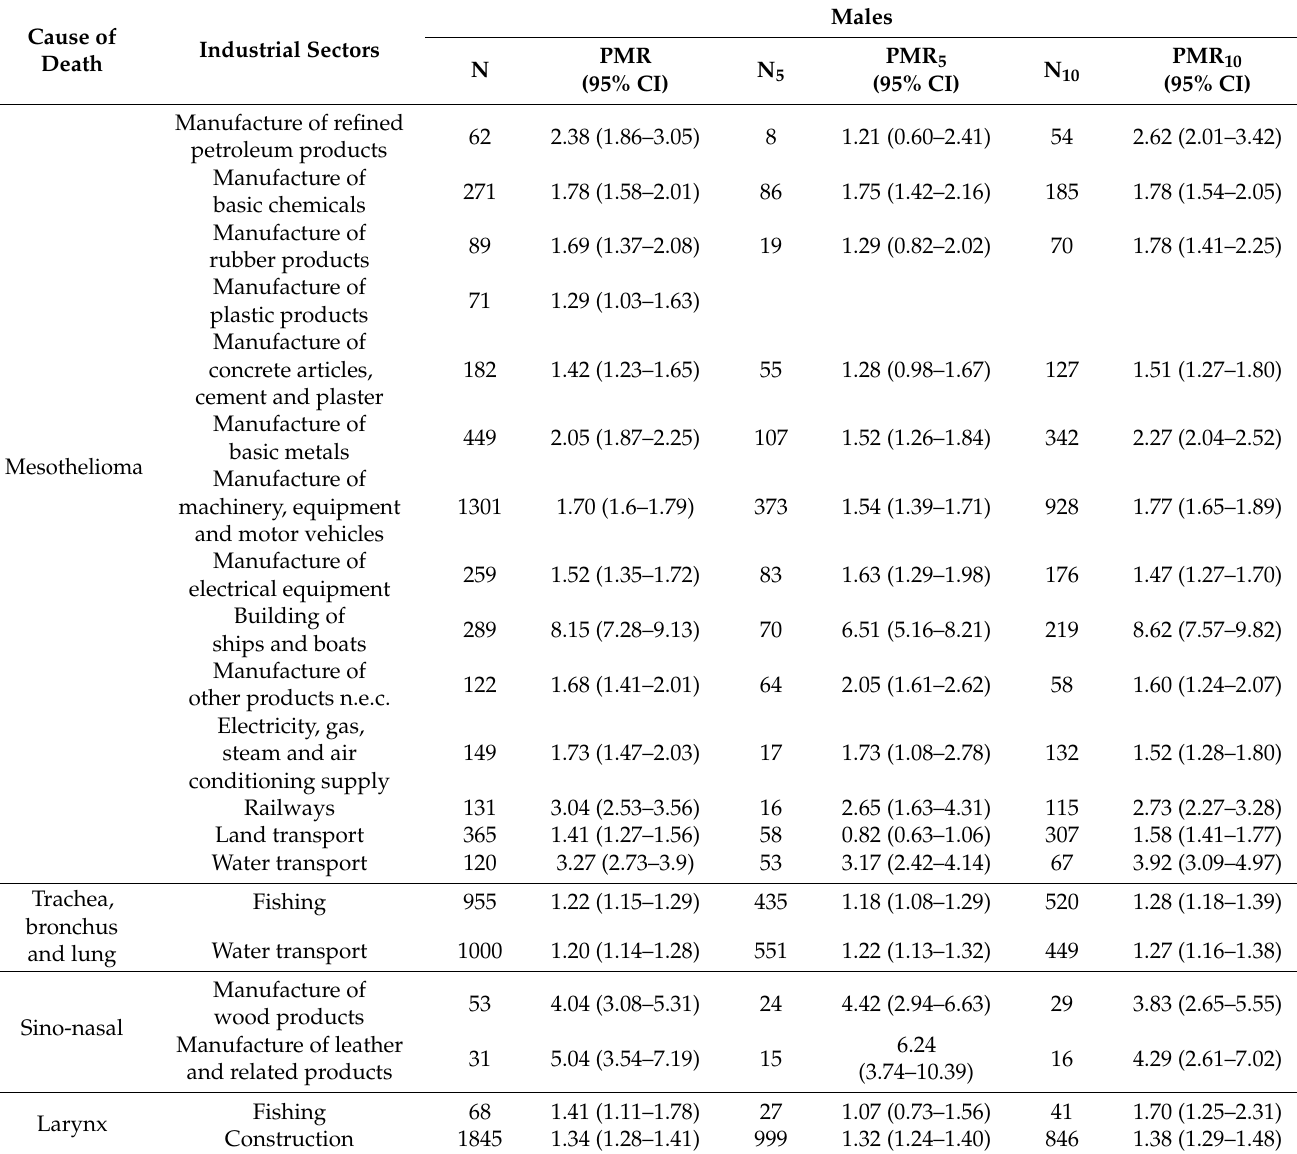
Table 2. Occupational Mortality Matrix (OMM) based on proportional mortality ratios (PMRs) by cause of death and industrial sector for males.